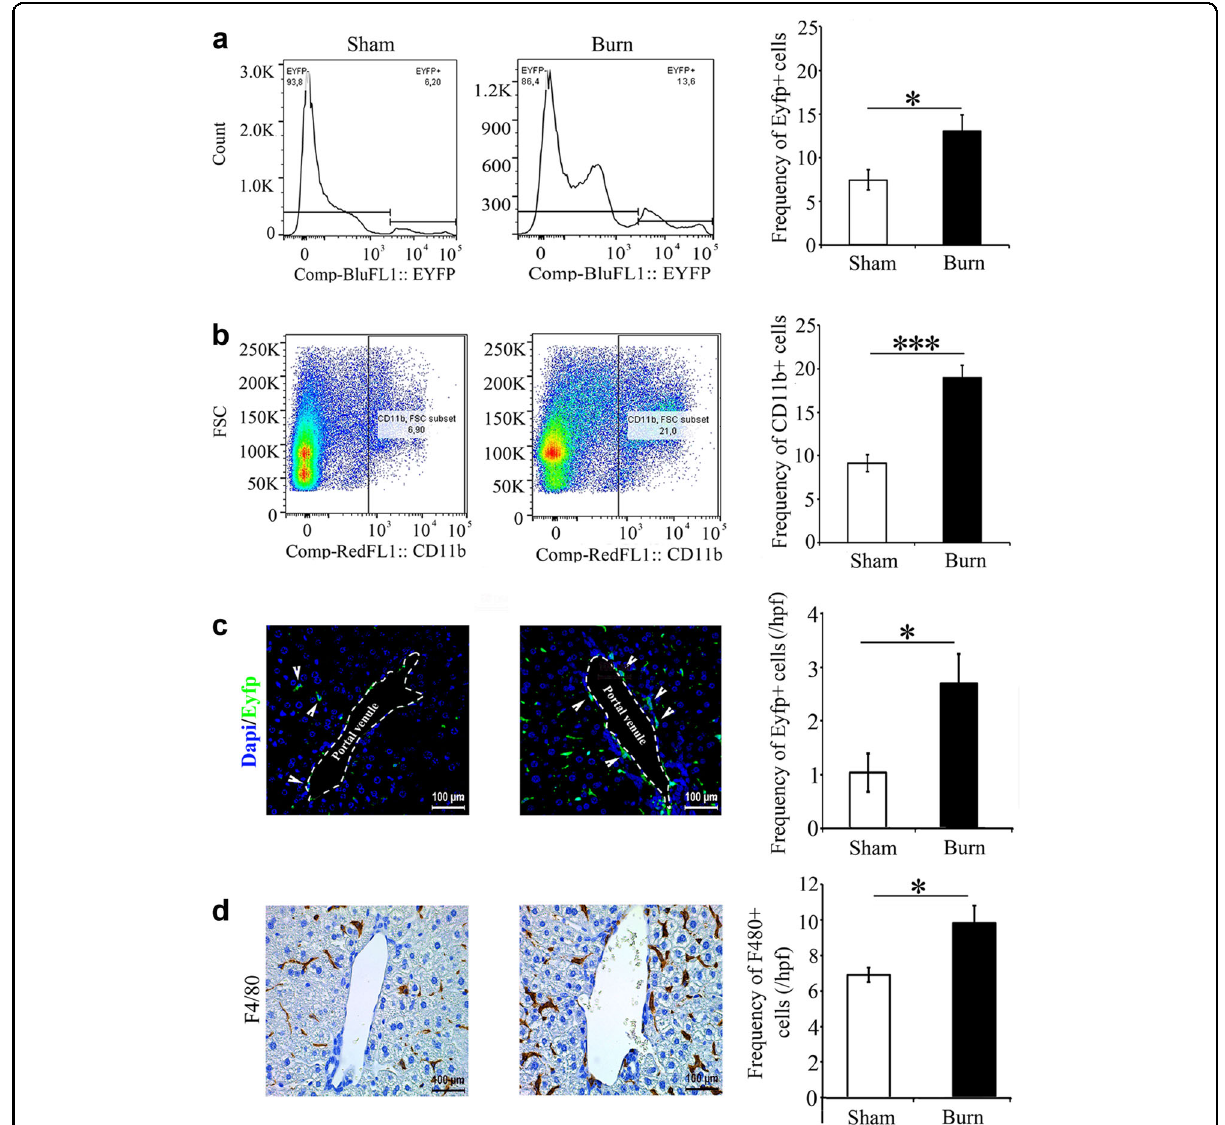
Fig. 2 Myeloid cells are recruited to the liver post-thermal injury . a , b Flow cytometry shows an increase in EYFP + and cd11b + cells. c Immuno fl uorescence of Lysz-Cre ROSA-EYFP livers shows an enrichment of EYFP + cells post-thermal injury, in particular around PVs. scale bar 100 μ m. d Immunohistochemistry staining for F4/80 + cells show an increase post-thermal injury in these cells in the liver and surrounding PV sites; n = 5 for all the panels, scale bar 100 μ m. * P < 0.05, and *** P <